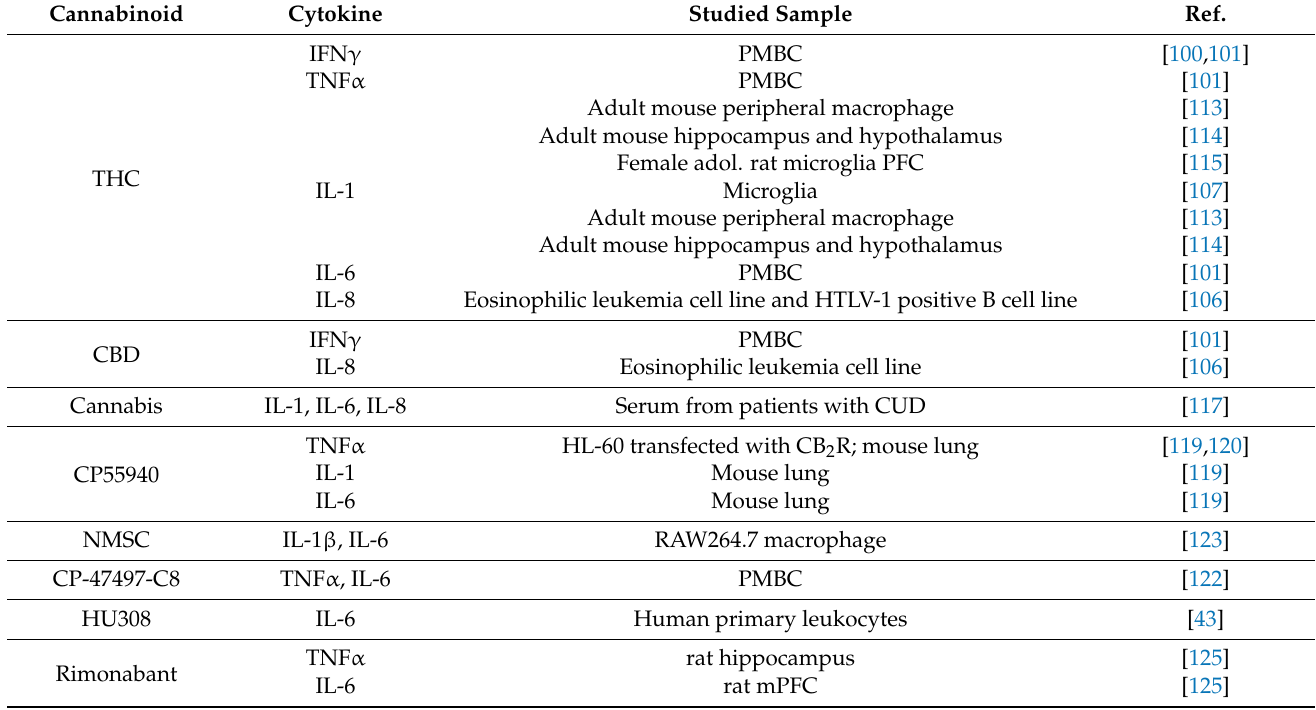
Table 1. Summary of cannabinoids known to increase pro-inflammatory cytokines. Studied Sample